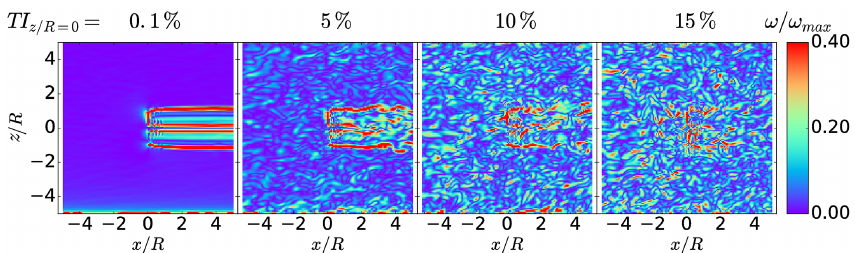
Figure 16. Instantaneous normalized vorticity ω/ω max in sheared flow for different longitudinal turbulence intensities TI x at hub position. Vertical plane at y/R =